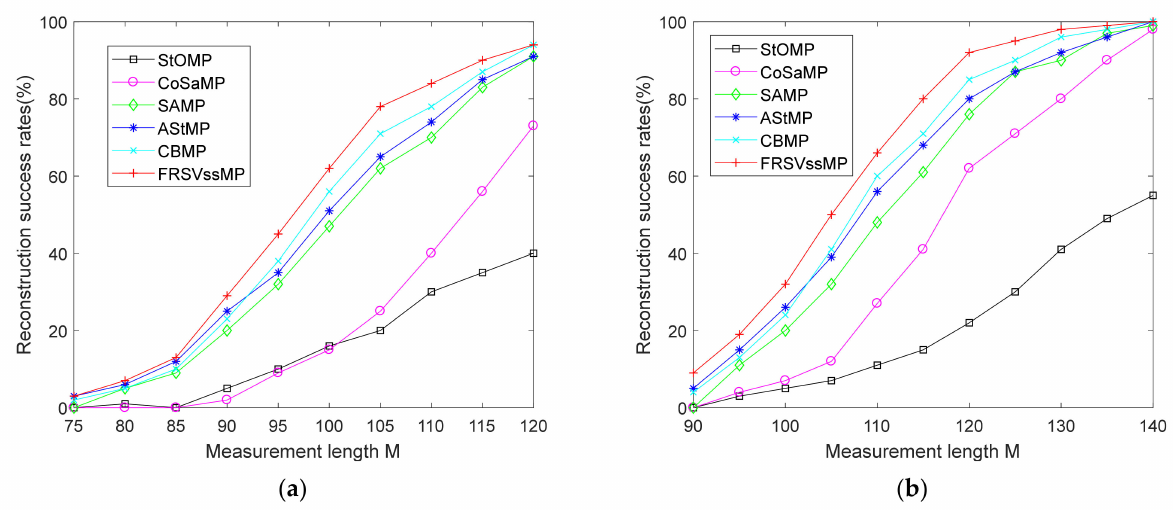
Figure 8. Reconstruction success rates vs. the measurement length. ( a ) Synthetic signals; ( b ) Real